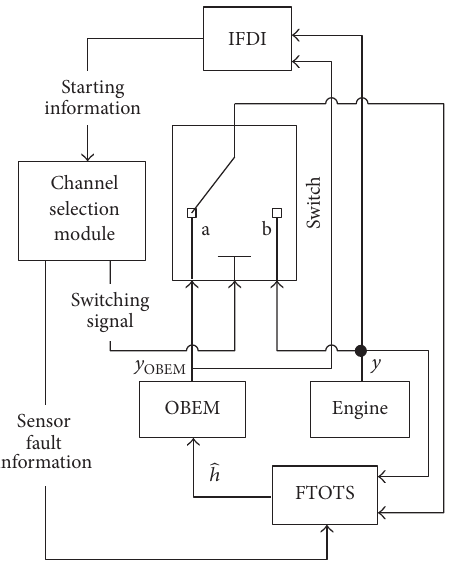
Figure 8: Switching channel between the FDI and the